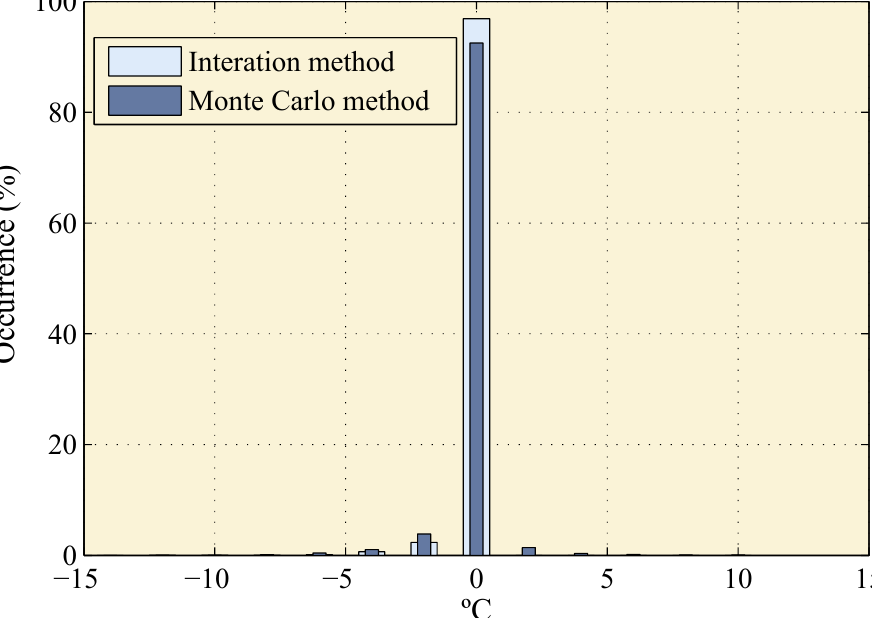
Figure 17. Differences between measured and effective ambient